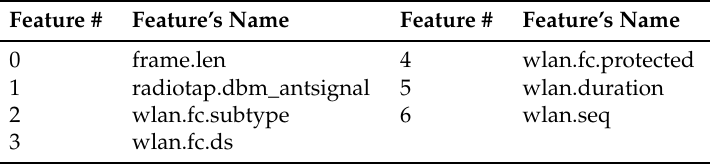
Table 7. Features selected for the second stage ML